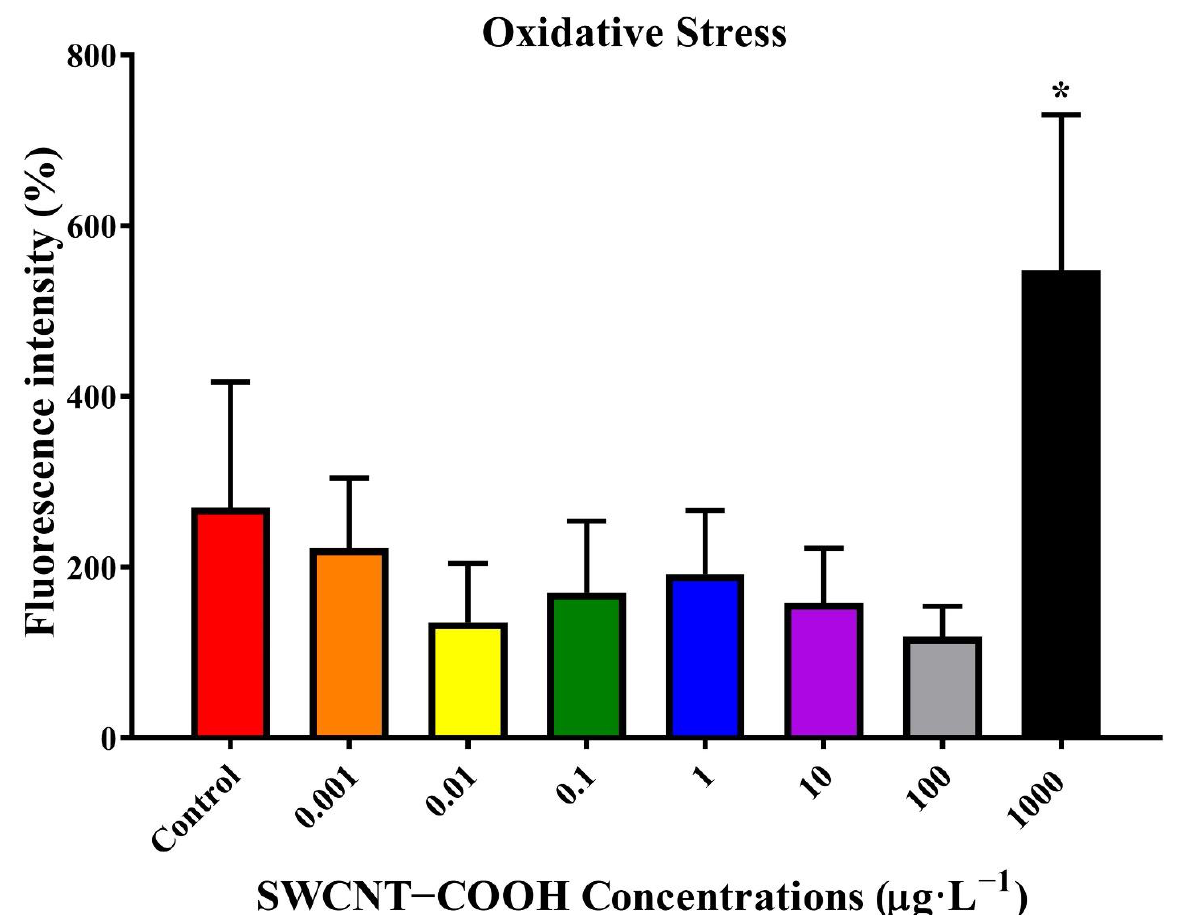
Figure 4. Effects of SWCNTs − COOH on C. elegans ROS generation after 8 days of exposure. * p < 0.05 as compared with the control.